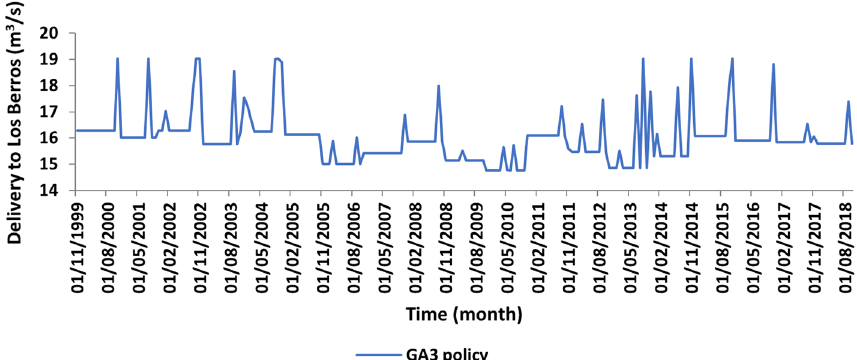
Fig. 16 The total monthly deliv‑ ery of water to the Los Berros water purification plant based on GA3